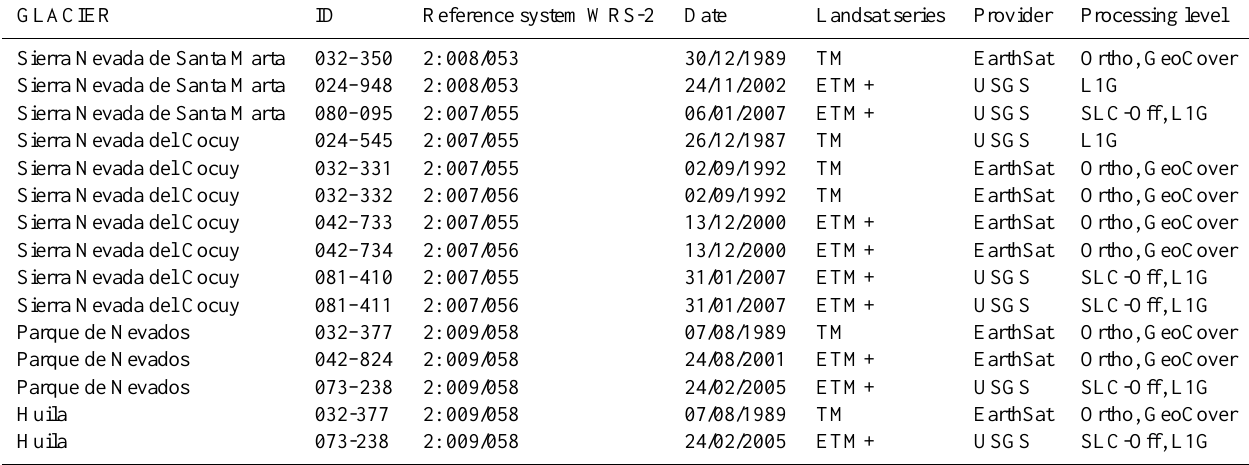
Table 2. Characteristics of Landsat imagery used in this study. Parque de Nevados includes Ruiz, Santa Isabel, and Tolima glaciers. GLACIER